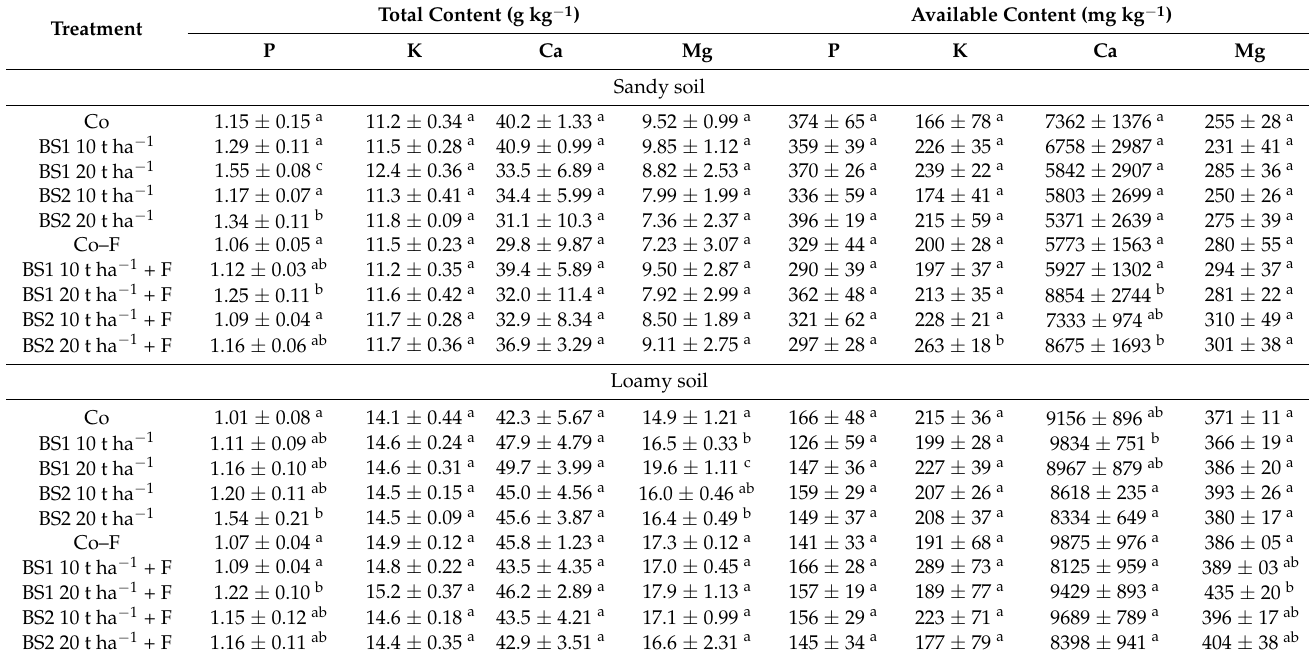
Table 4. Contents of total and available macro–nutrients (mean ± standard deviation for 2018–2020).